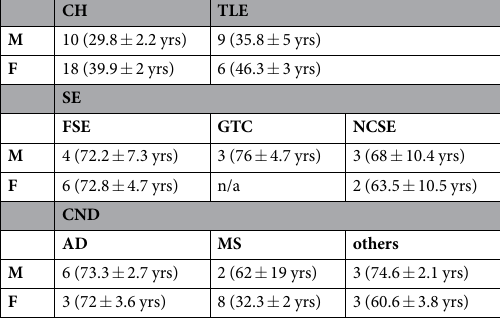
Table 1. Summary of patient group demographics. Key; AD, Alzheimer’s disease; CH, control (headache); F, female; FSE, focal status epilepticus; GTC, generalized tonic clonic seizures; M, male; MS, multiple sclerosis; n/a; not applicable; NCSE, nonconvulsive status epilepticus; SE, status epilepticus; TLE, temporal lobe